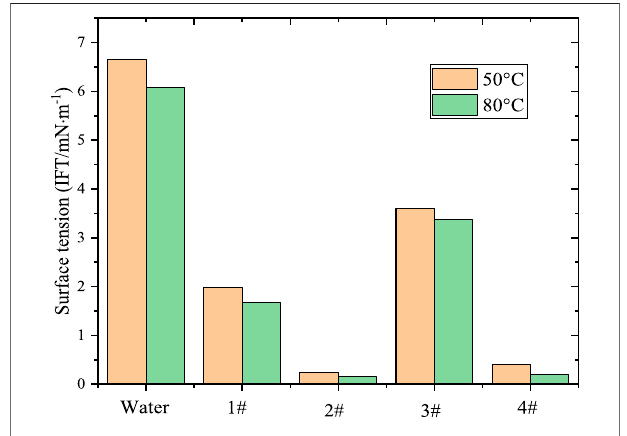
FIGURE 6 | Experiment oil – water sample. (A) 50 ° C. (B) 80 ° C.